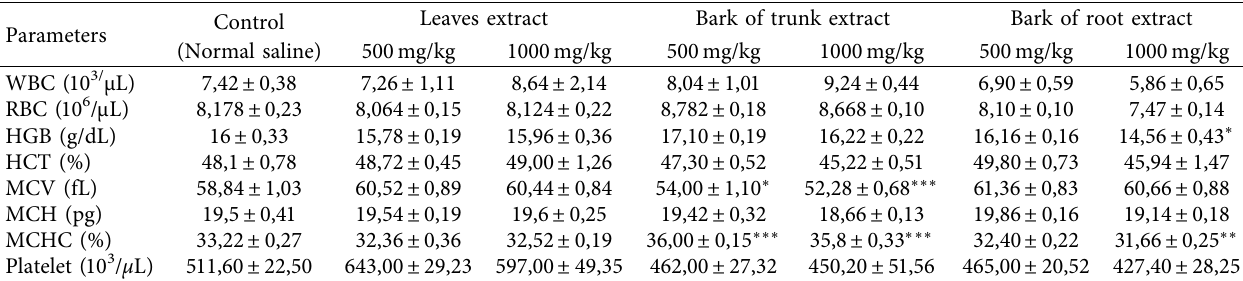
Table 4: Hematological parameters for rats after 28-day treatment with hydroethanolic leaf, trunk of bark, and root of bark of P. santalinoides .